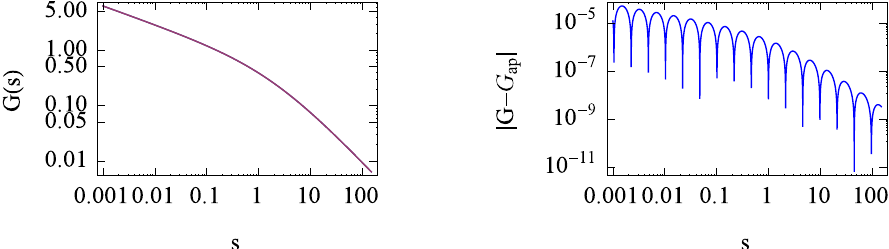
Figure 7. Approximation of the transfer function G ( s ) for a fractional relaxation equation given by Equation (94). The left panel shows the exact transfer function G ( s ) with u (cid:28) = 1 = 2 , and q = 2 = 3 in connection with the approximation using Thiele’s algorithm. The right panel shows the local error between the exact function and its